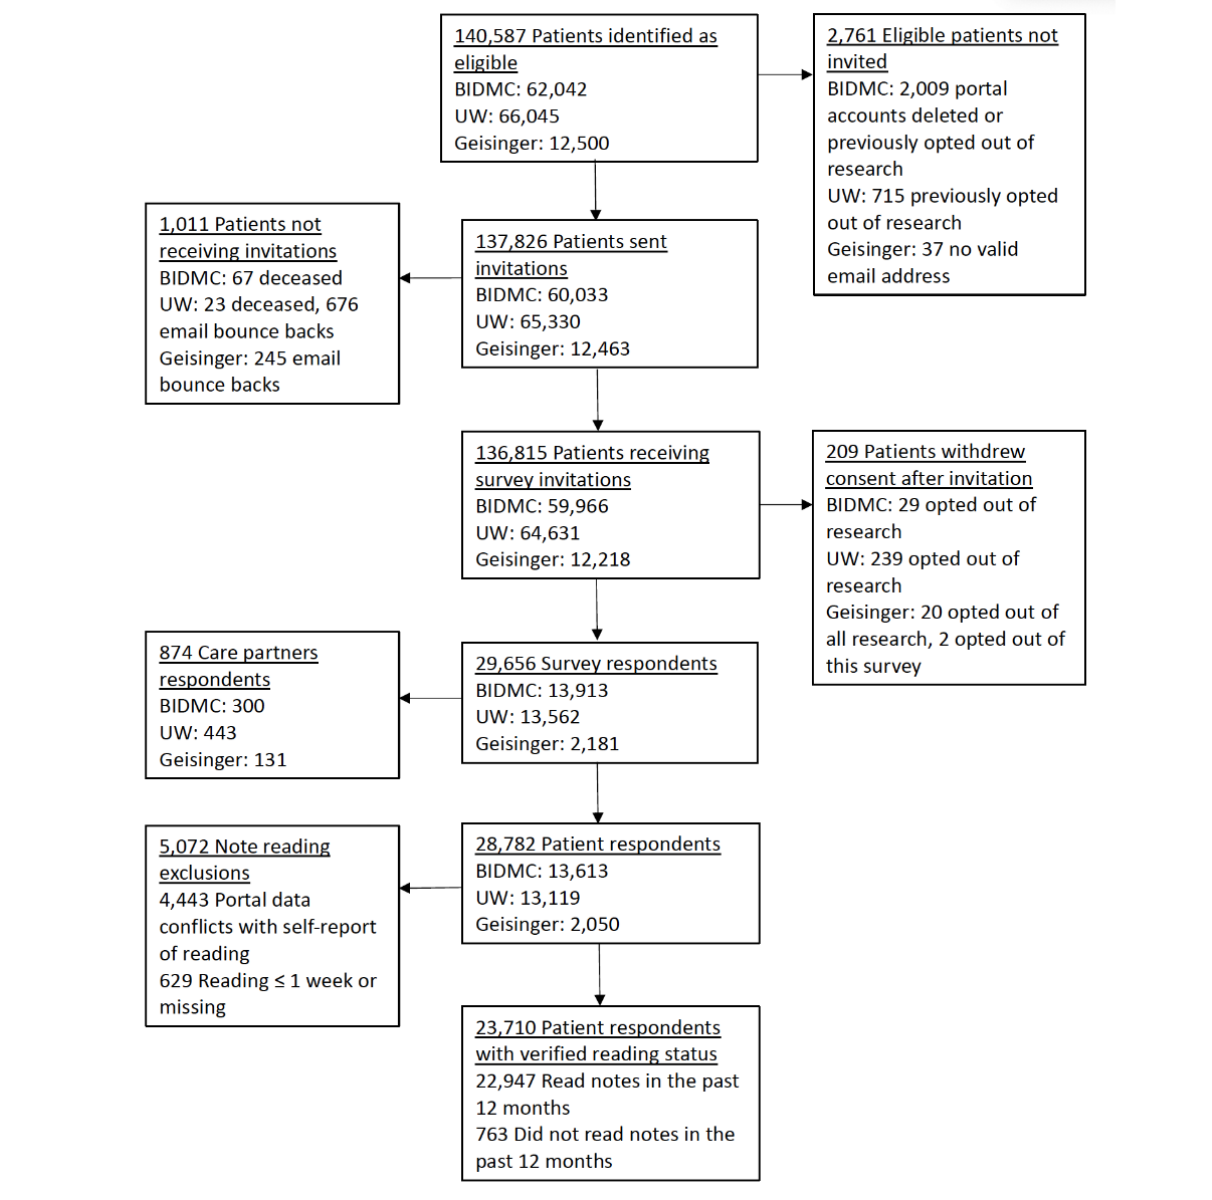
Figure 1. Study flow diagram. BIDMC: Beth Israel Deaconess Medical Center; UW: University of Washington